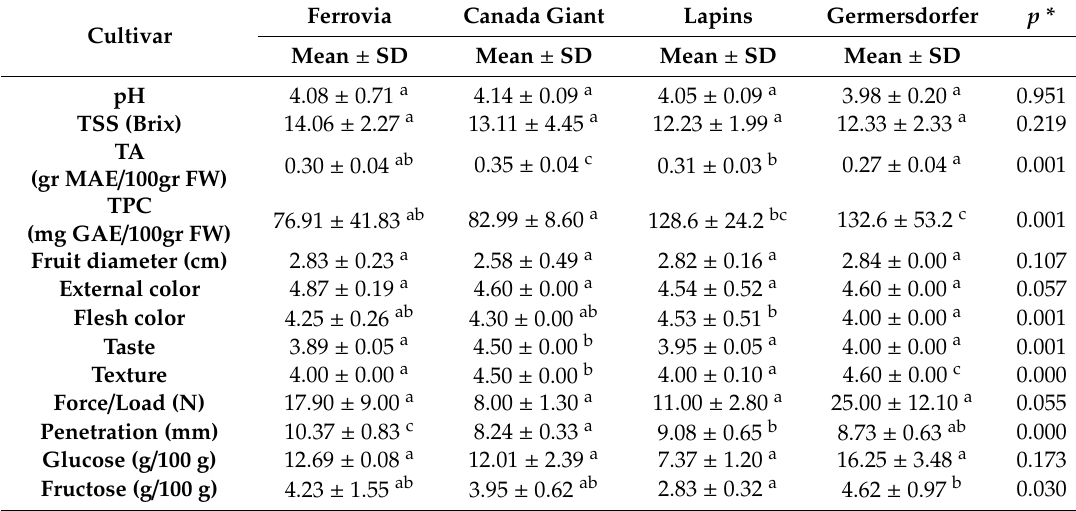
Table 1. Mean values and standard deviations (SD) of conventional quality parameters and sugars of the cherry samples tested. Ferrovia Canada Giant Cultivar